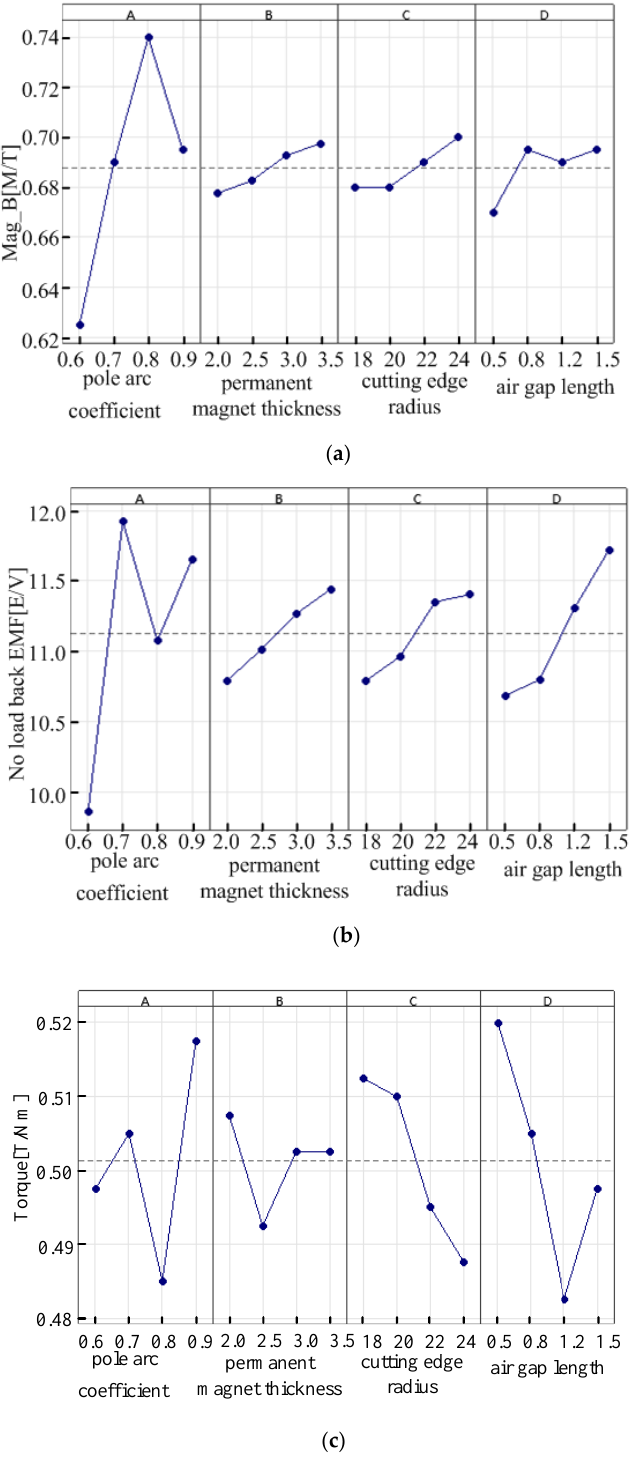
Figure 5. Influence of the parameter influence factors on target performance. ( a ) The effect of the parameter level factor on air-gap magnetic density. ( b ) The effect of the parameter level factor on no-load back EMF. ( c ) Effect of the parameter level factor on the output torque.